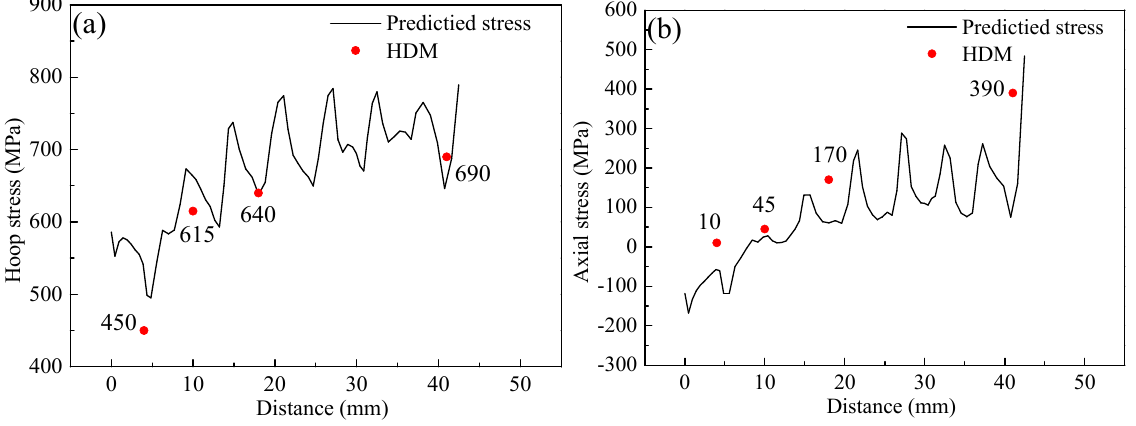
Figure 18. Residual stress predicted by SYSWELD vs. measured by HDM: ( a ) hoop stress, ( b ) axial stress.